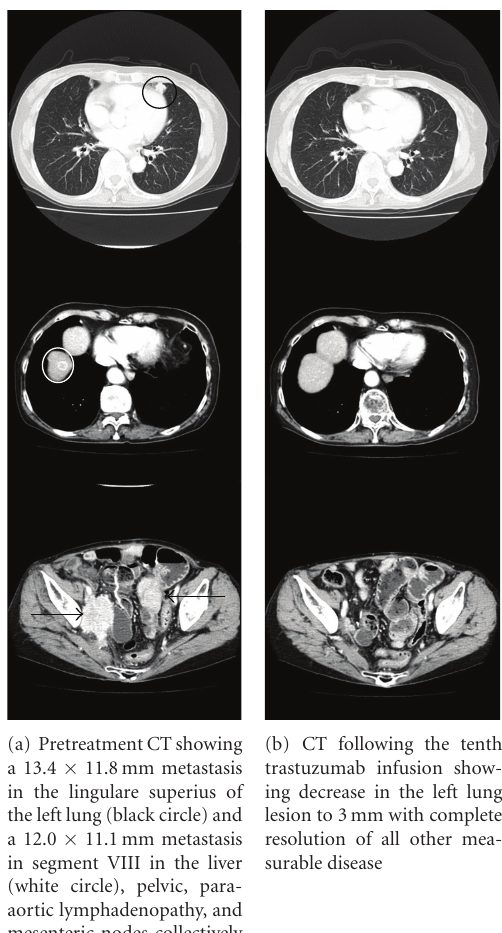
Figure 2: CT image of the metastatic